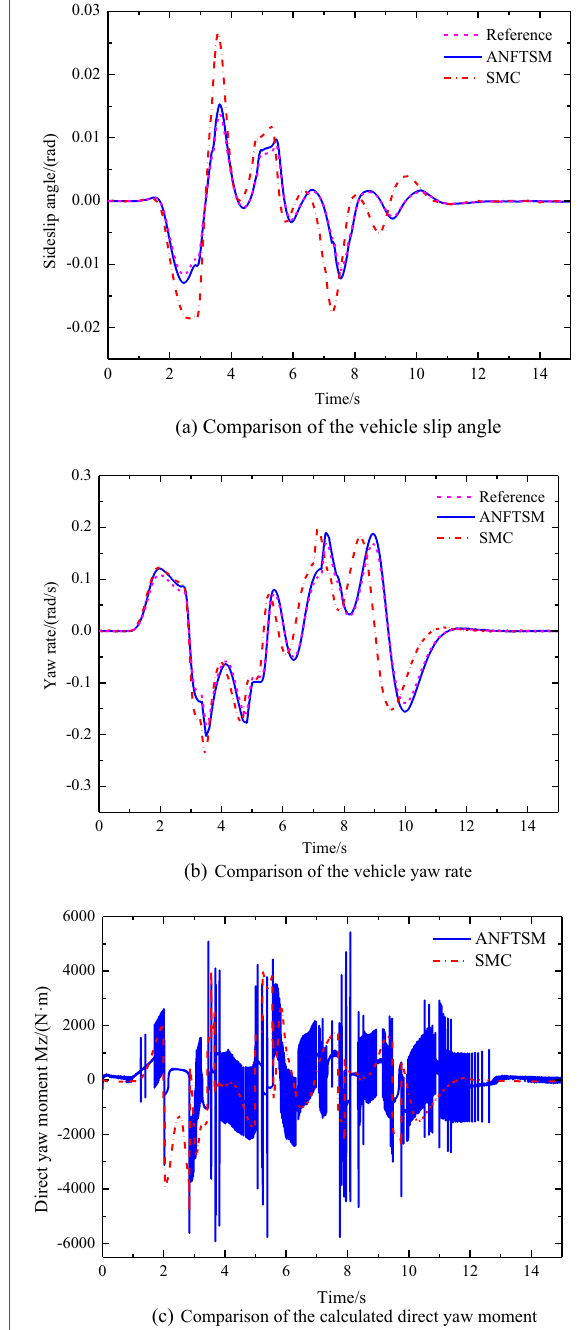
(c) Comparison of the calculated direct yaw moment Figure 7 Simulation results comparison between the ANFTSM and the SMC ( μ =